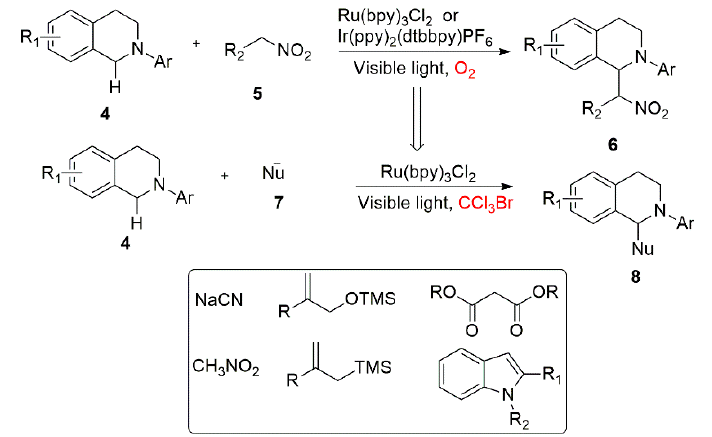
Scheme 5. Visible light catalyzed aza Henry